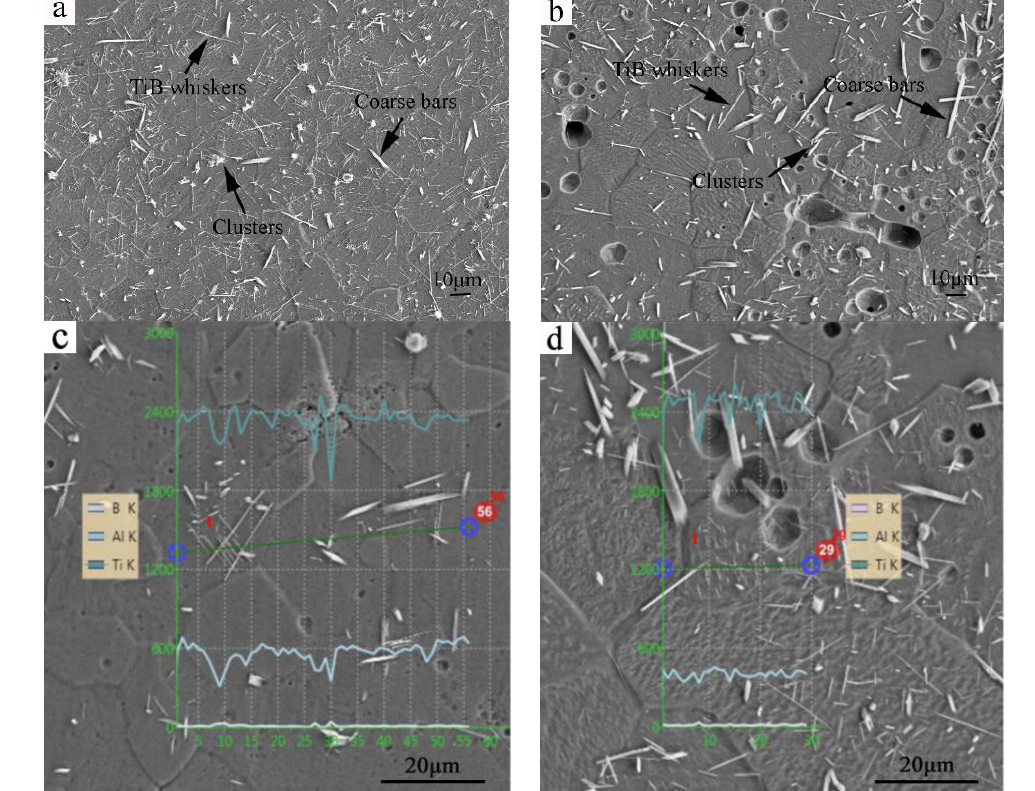
Figure 6. SEM images of sintered alloy: ( a ) Ti-7Al-0.2B; ( b ) TiH 2 -7Al-0.2B. EDS images of sintered alloy: ( c ) Ti-7Al-0.2B; ( d ) TiH 2 -7Al-0.2B.